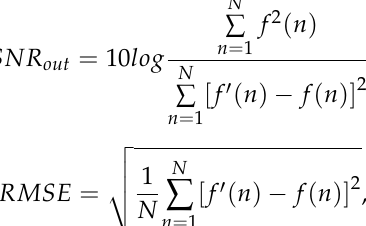
Figure 4. Decomposition result of the noisy Bumps signal.